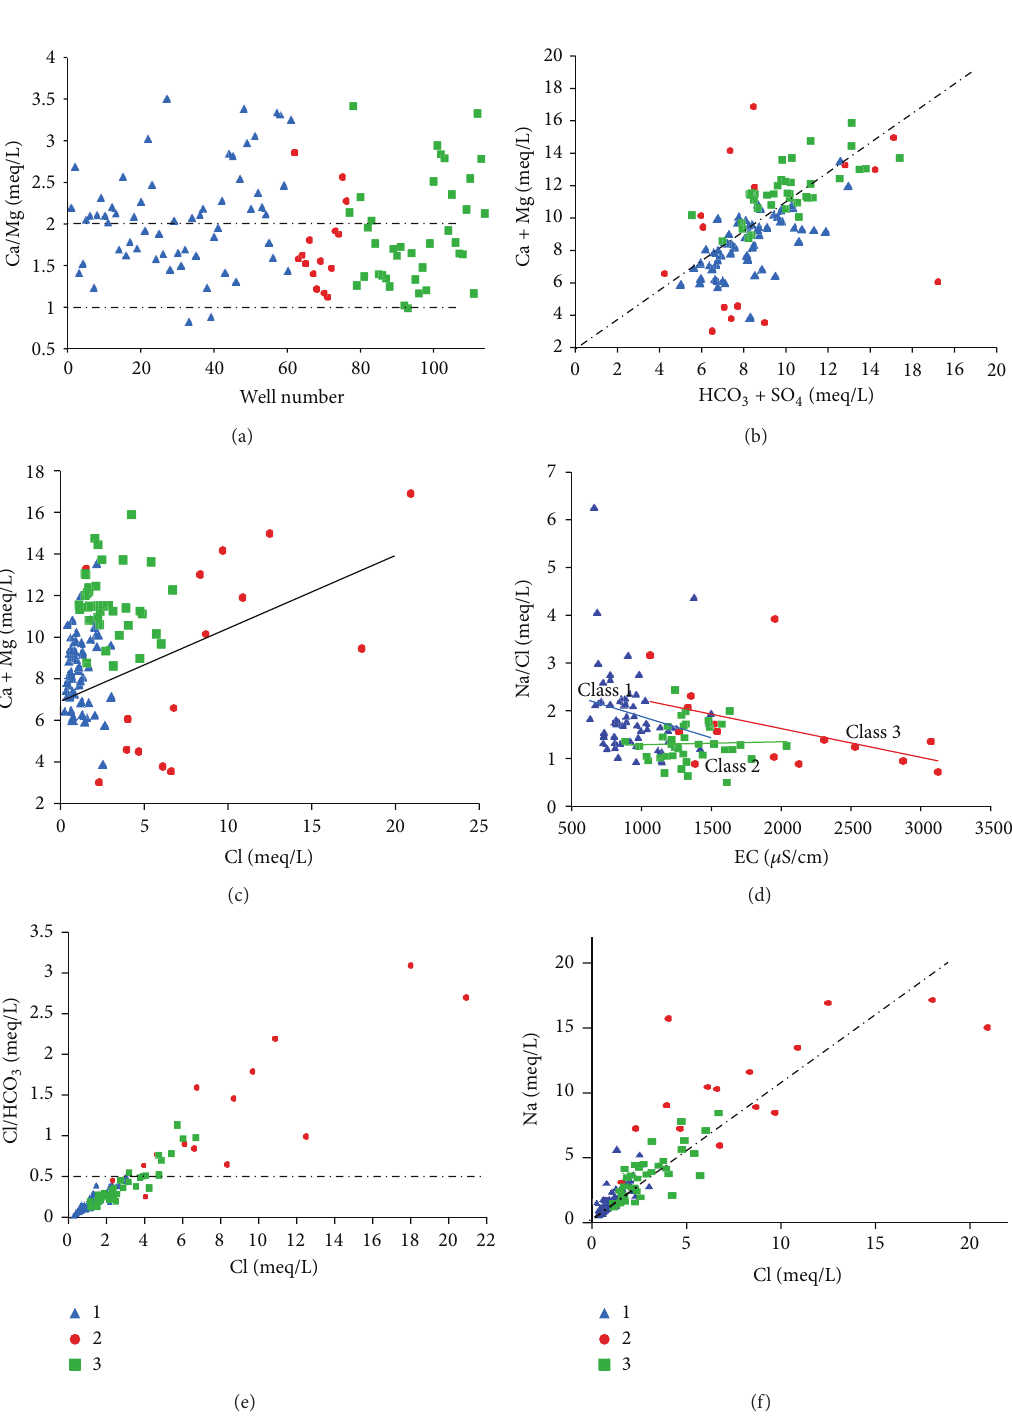
Figure 5: Distribution of ionic ratios for major groundwater ions from the study